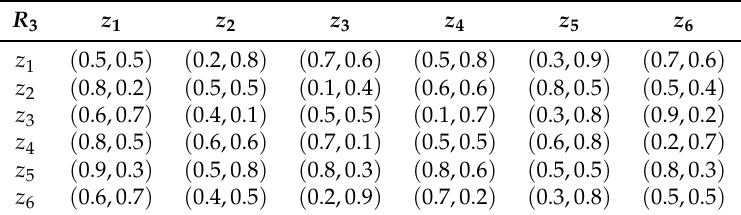
Table 3. PFPR of the second stock specialist.